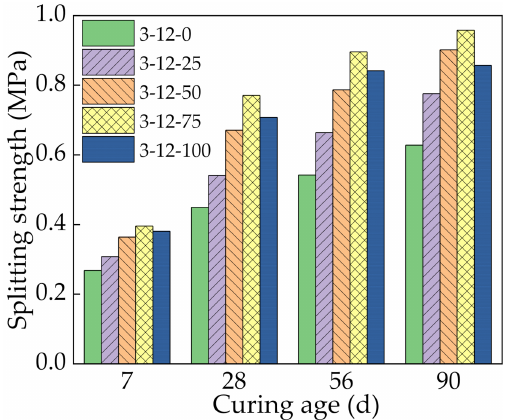
Figure 8. Indirect tensile strength with different steel slag